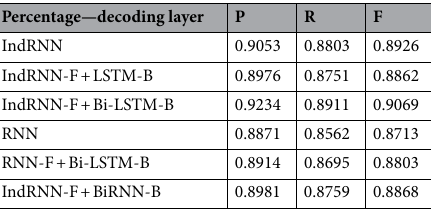
Table 3. Effect of various coding and decoding layer network models on the evaluation criteria values.